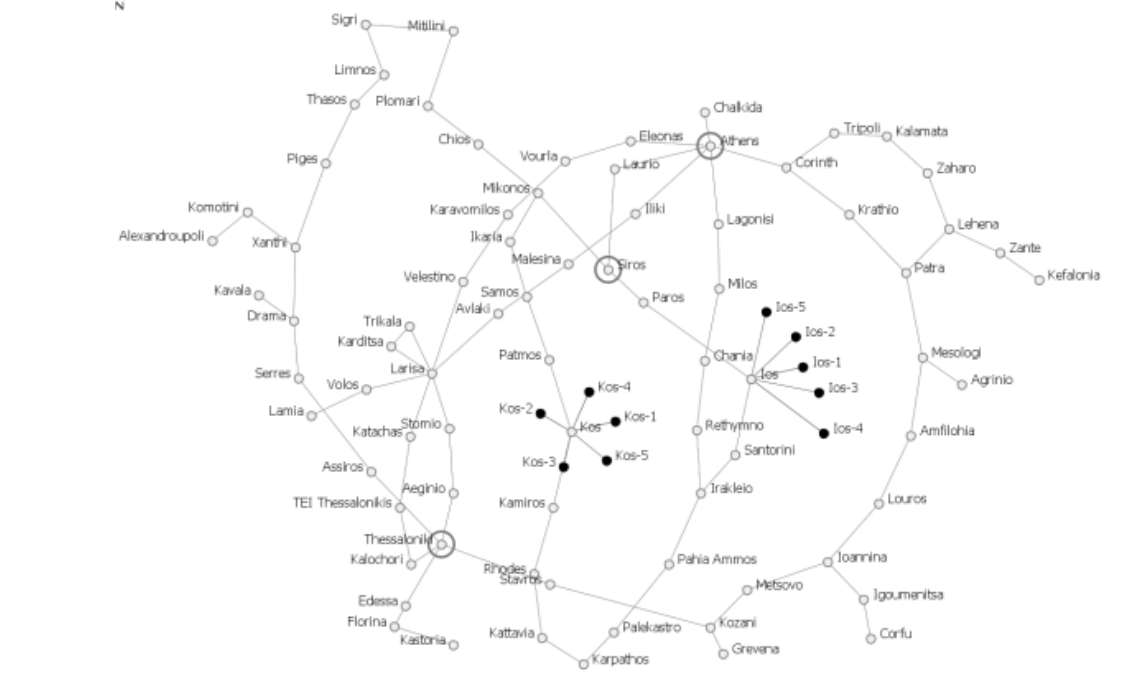
Figure 6. GRNET network topology with new deployments